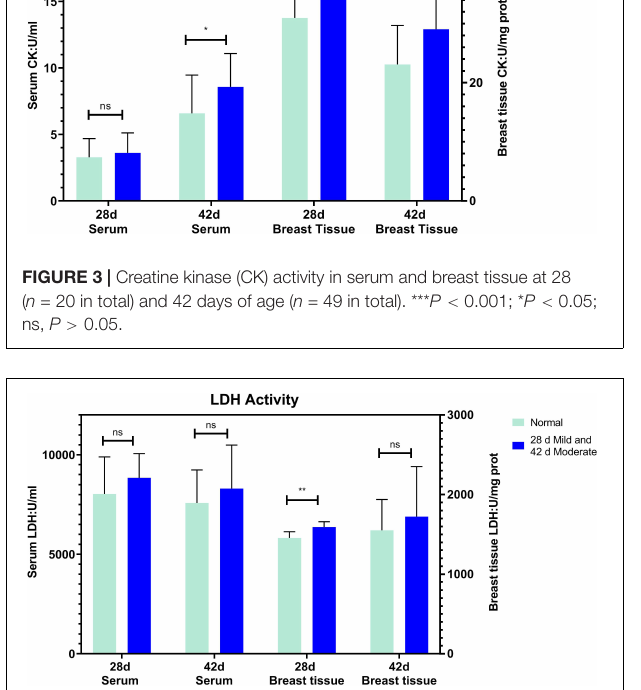
FIGURE 4 | Lactate dehydrogenase activity in serum and breast tissue at 28 ( n = 20 in total) and 42 days of age ( n = 49 in total). ** P < 0.01; ns, P > 0.05.